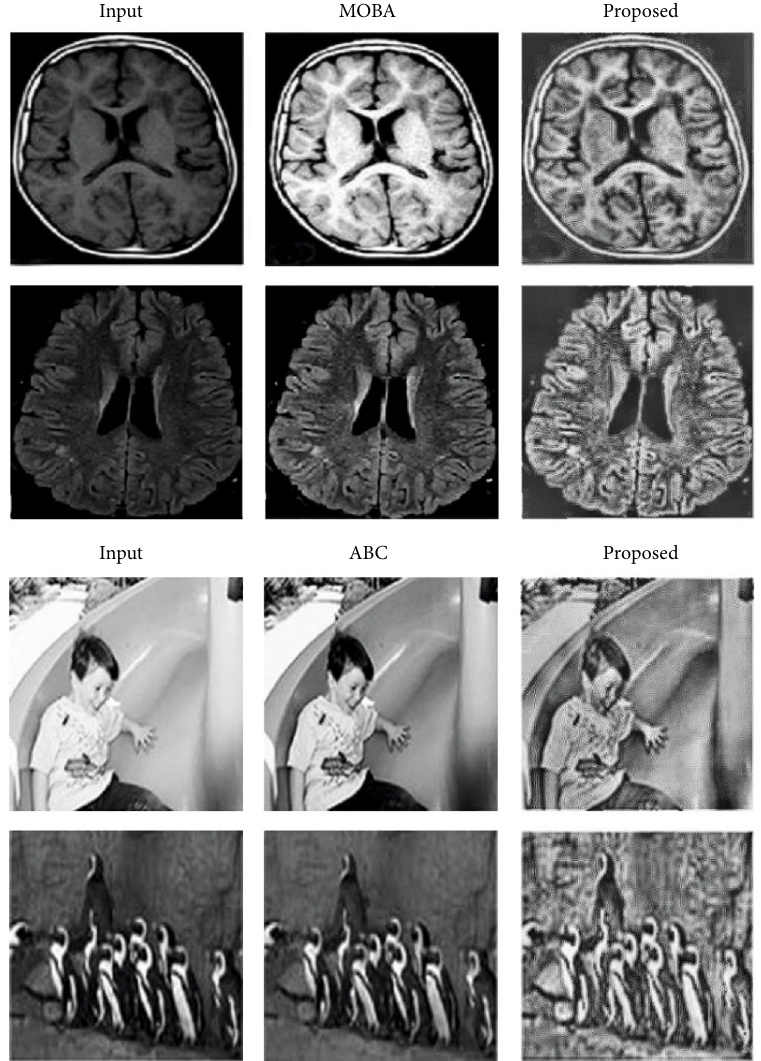
Figure 4: Summary of the example of the test comparison between the original image and the results from the MOBA [60]), ABC [59], and the proposed